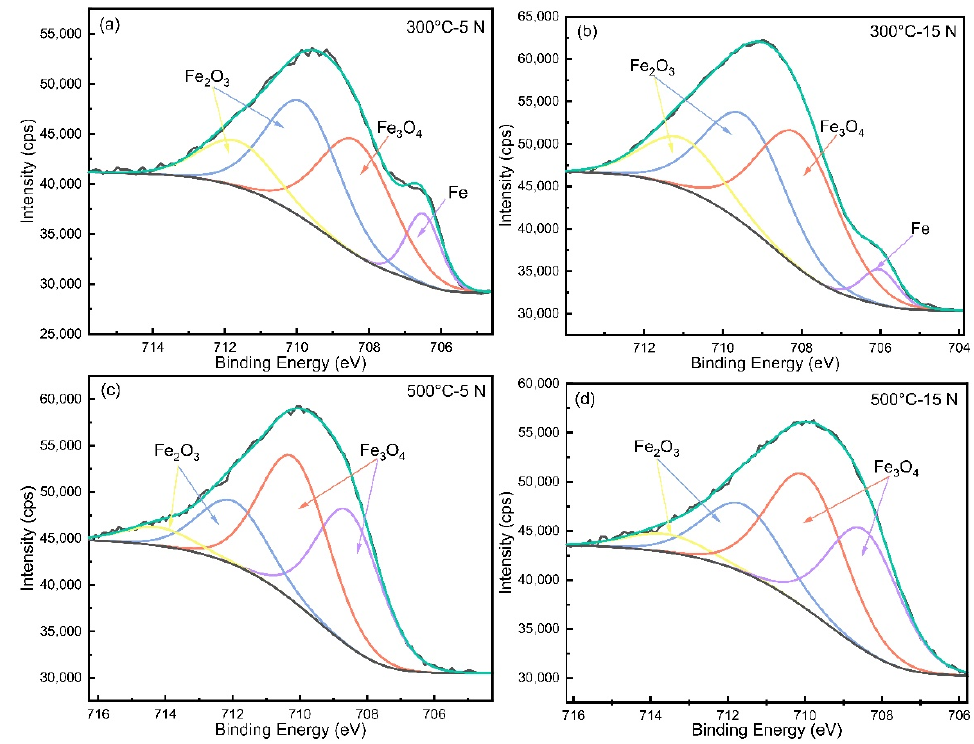
Figure 7. Spectra of Fe 2p of wear tracks under different conditions. ( a ) 300 °C–5 N, ( b ) 300 °C–15 N, ( c ) 500 °C–5 N, and ( d ) 500 °C–15 N. ( c ) 500 ◦ C–5 N, and ( d ) 500 ◦ C–15